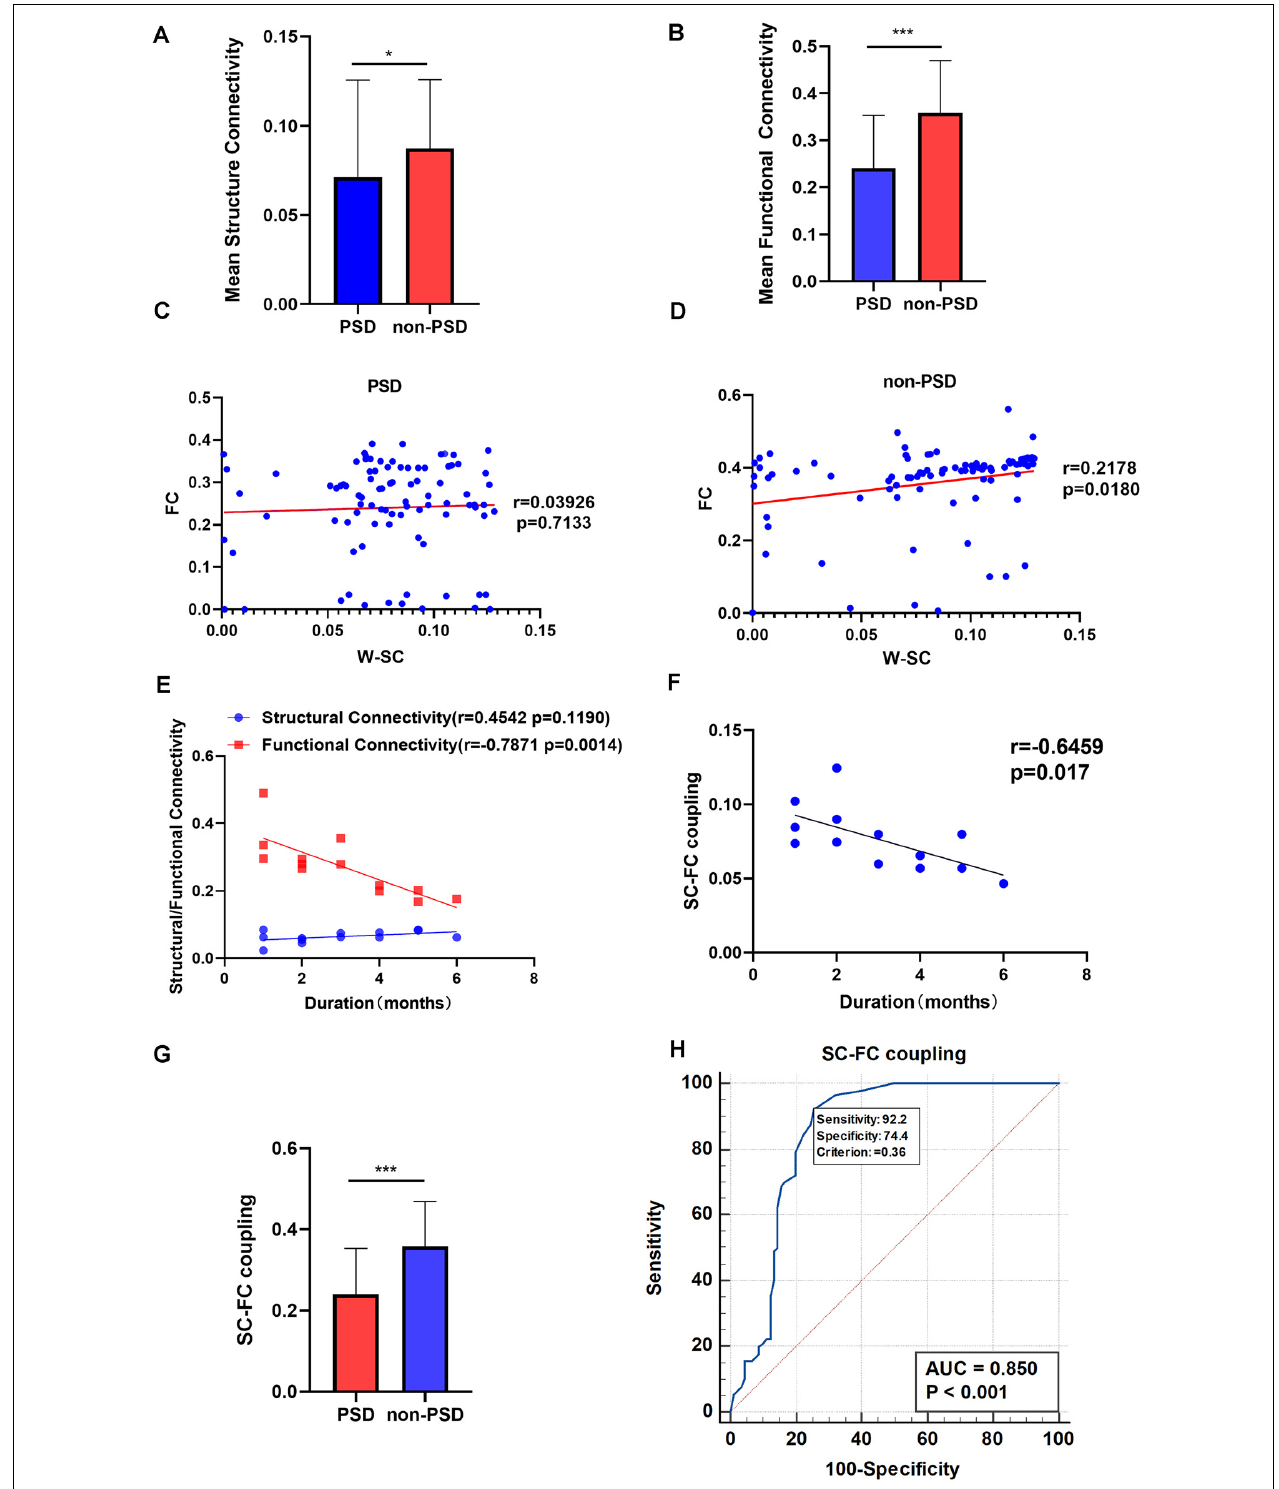
FIGURE 7 | (A) The mean SC in the PSD and the non-PSD groups. (B) The mean FC in the PSD and the non-PSD groups. (C) The SC-FC coupling in the PSD group. (D) The SC-FC coupling in non-PSD group. (E) Correlation between the mean SC/ FC and duration of PSD. (F) Correlation between the SC-FC coupling and duration of PSD. (G) The SC-FC coupling in the PSD and the non-PSD groups. (H) A receiver operating characteristic (ROC) curve for PSD and non-PSD. * p < 0.05, *** p < 0.001. SC, structural connectivity; FC, functional connectivity; W-SC, weighted SC.